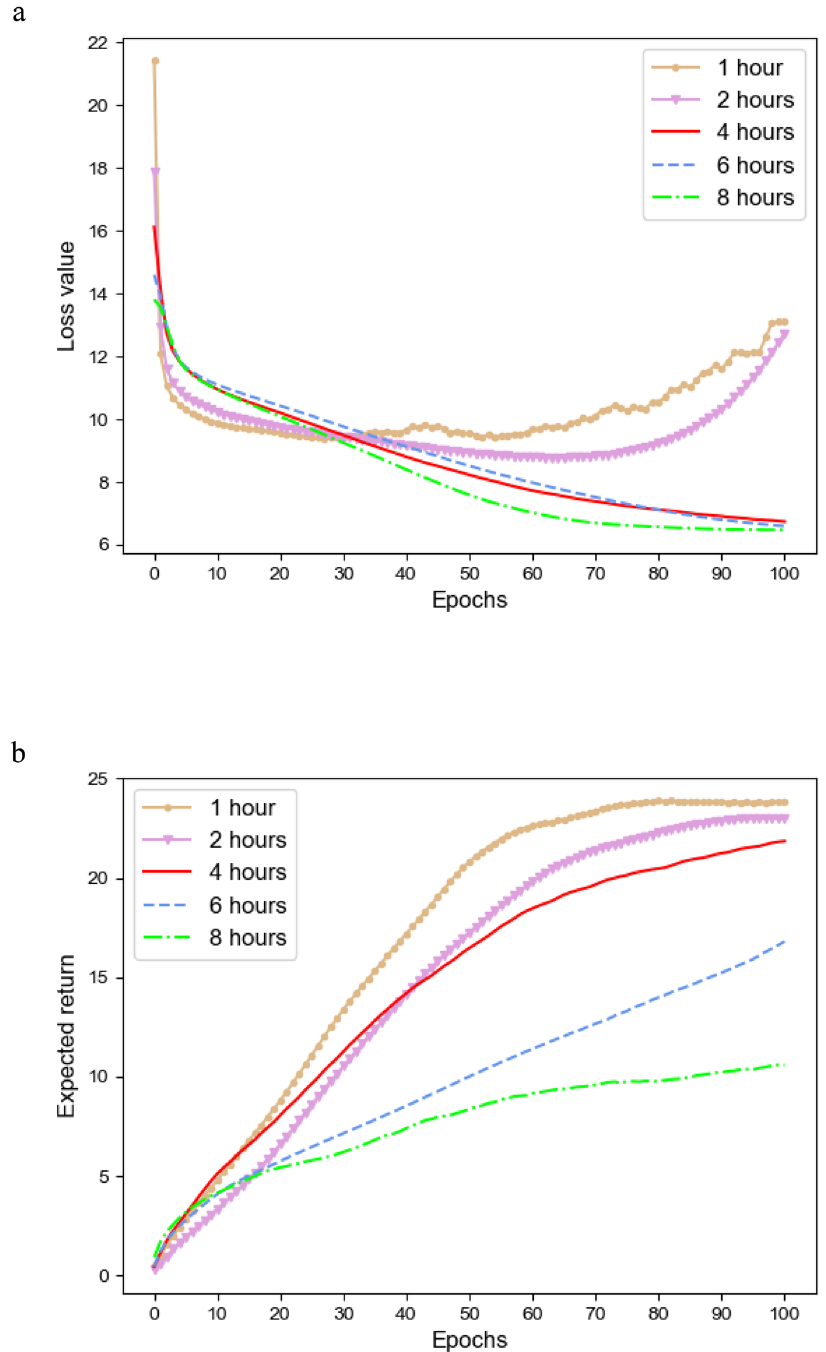
Fig. 4 Performance results of different binning intervals at each learning epoch. The patient trajectories are discretized into different binning intervals, 1 h, 2 h, 4 h, 6 h, and 8 h. a The loss value of different binning intervals in training. b The expected return of different binning intervals in the training